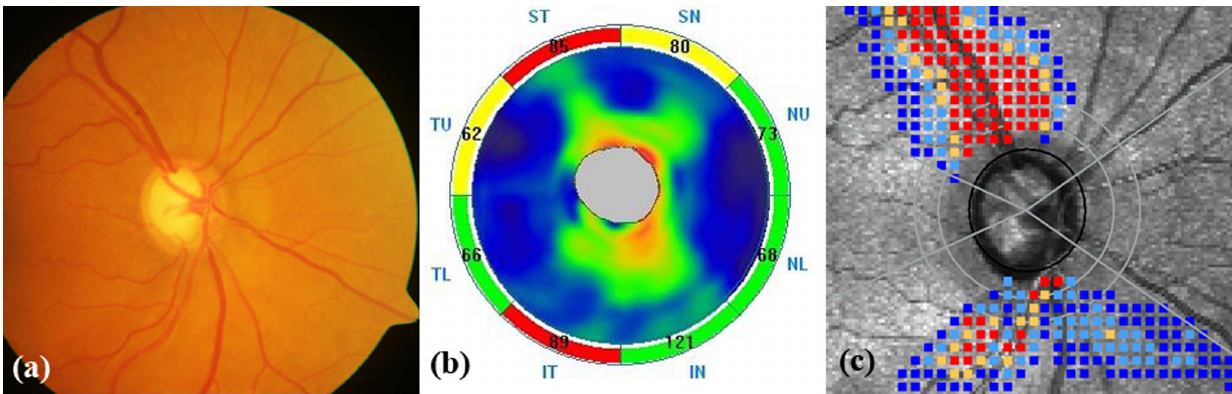
Figure 2. Representative image of an eye in the preperimetric glaucoma group showing glaucomatous optic disc with retinal nerve fiber layer (RNFL) defects superiorly and inferiorly (a), corresponding RNFL thickness abnormalities on spectral domain optic coherence tomography (b) and corresponding abnormal RNFL birefringence on GDx enhanced corneal compensation (c).